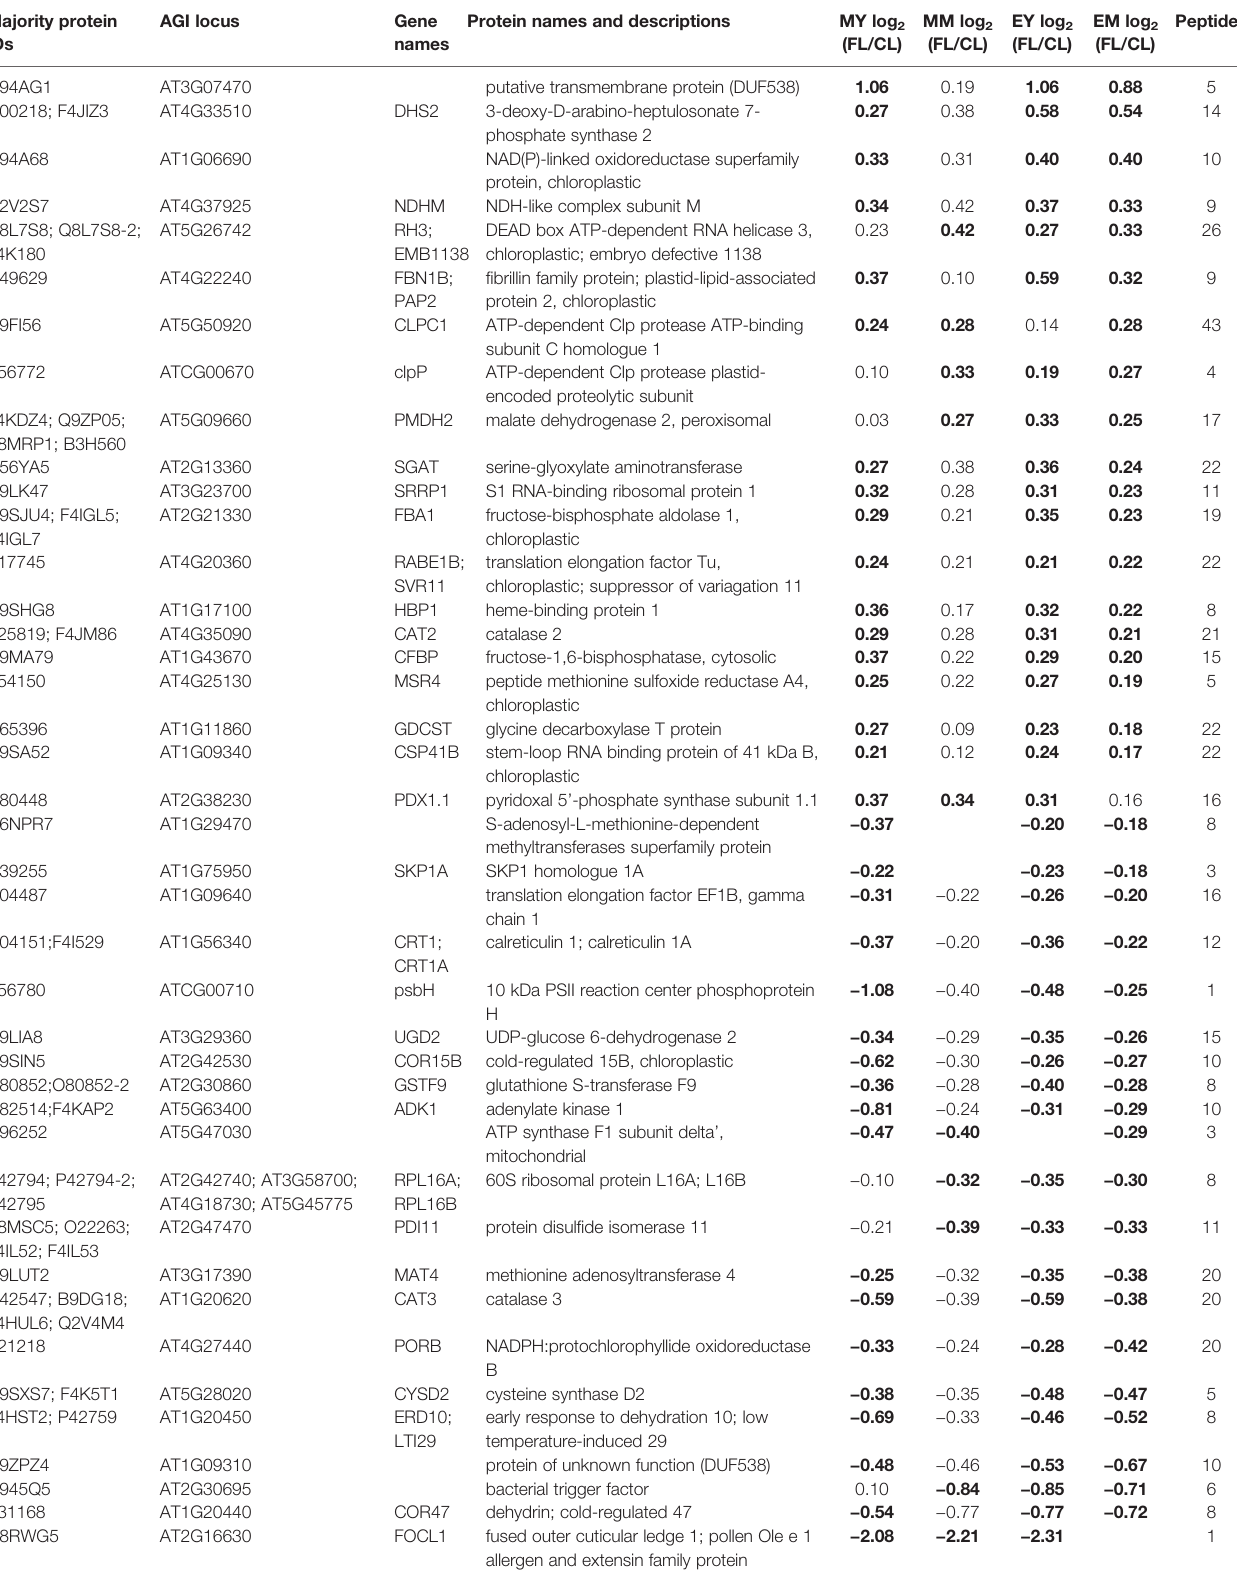
TABLE 2 | Proteins with signi fi cant responses to FL in three of the four samples (MY, MM, EY, and EM). Signi fi cant changes are indicated by bold numbers. Majority protein AGI IDs